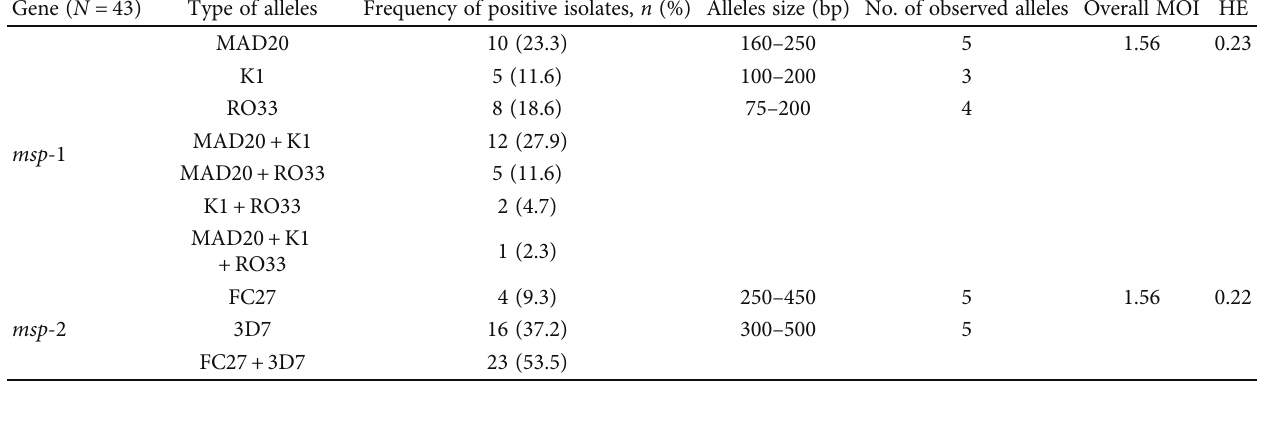
Table 3: Genetic diversity of msp -1 and msp -2 in Plasmodium falciparum population in Boset and Badewacho districts, Southwest Ethiopia. Gene ( N = 43 ) Type of alleles